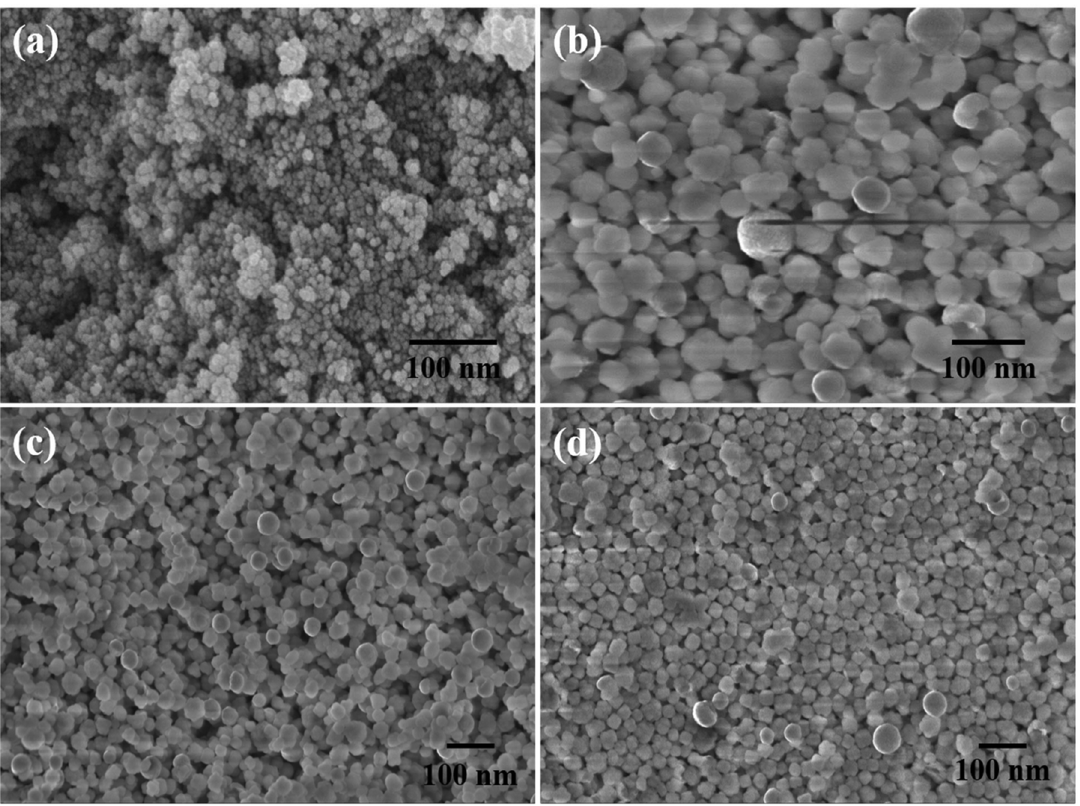
Figure 4. FESEM scans of ( a ) Fe 3 O 4 nanoparticles, ( b ) IRMOF-3, ( c ) Fe3O4@IRMOF-3, and ( d ) Fe 3 O 4 @IRMOF-3/FA [118]. Reprinted with permission from Ref. [118]. Copyright 2016 Royal Society of Chemistry.